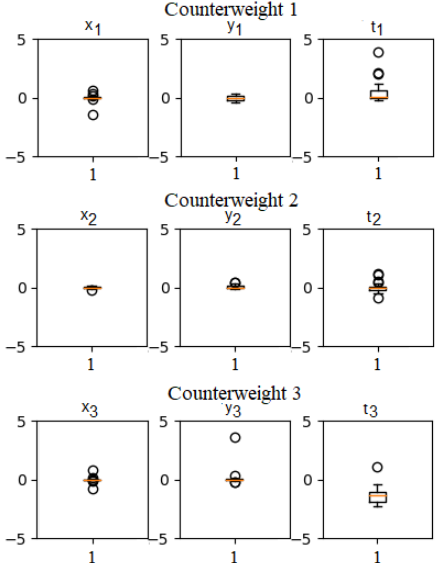
Figure 6. Box plots of partial derivatives with respect to each optimization variable when using three